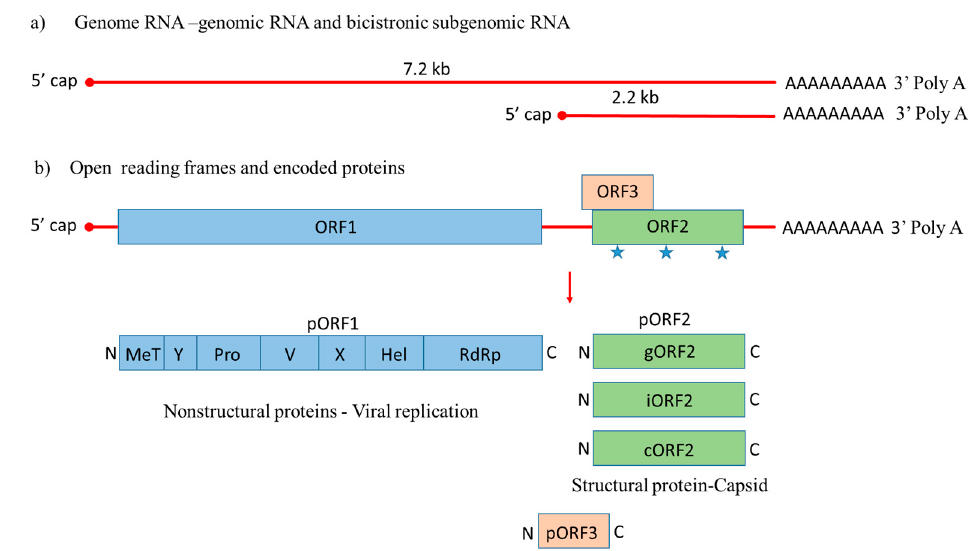
Figure 1. Genome organization of Hepatitis E virus. ( a ) Hepatitis E-Virus (HEV) genome generates the full-length genomic RNA and subgenomic RNA with 5 ′ cap, 3 ′ Poly A tail, 5 ′ UTR and 3 ′ UTR. ( b ) The genomic RNA has three open reading frames: ORF1 , ORF2 , and ORF3 . ORF1 encodes the nonstructural proteins for viral replication; ORF2 is translated into the capsid protein with three potential glycosylation sites ( ), with a small multifunctional protein encoded by ORF3 . Three different capsid proteins have been discovered in vitro during infection, i.e., gORF2-glycosylated, iORF2-infectious and cORF2-cleaved ORF2.